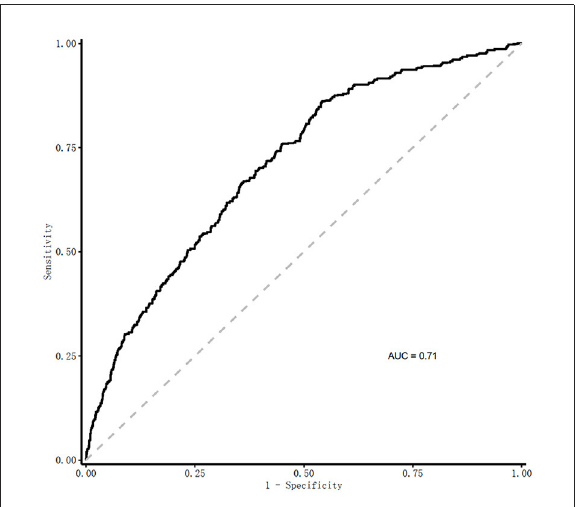
FIGURE3 AUC for the detection of frailty by the frailty prediction model. Predicted risk of 30-day frailty = [1/(1 + e − riskscore )], where riskscore = − 0.106+0.034 × age+0.796 × sex − 0.361 × vision dysfunction+0.373 × hearing dysfunction+0.408 × urination dysfunction − 0.012 × ADL+0.064 × depression − 0.139 × nutritional status − 0.007 × hemoglobin − 0.034 ×